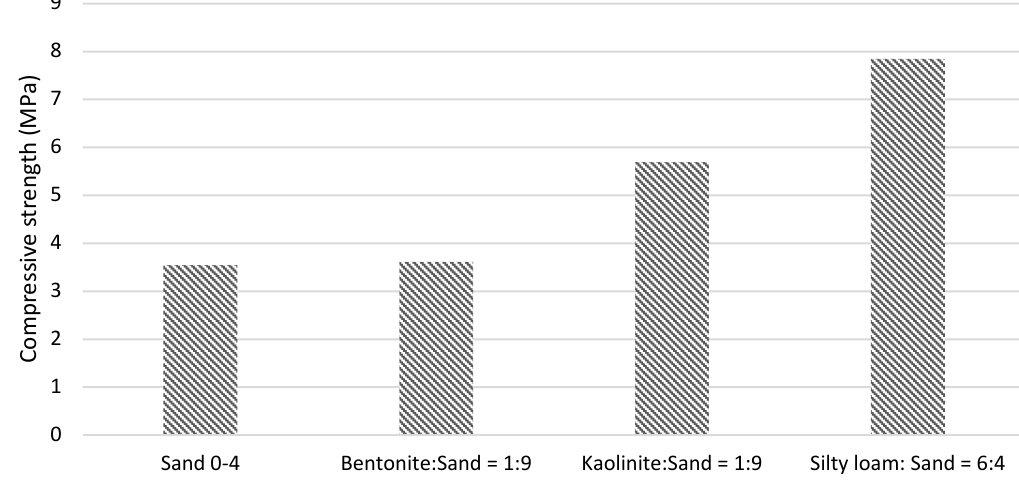
Figure 3. Compressive strengths of adobe bricks with the addition of 6% cement. Based on [4].